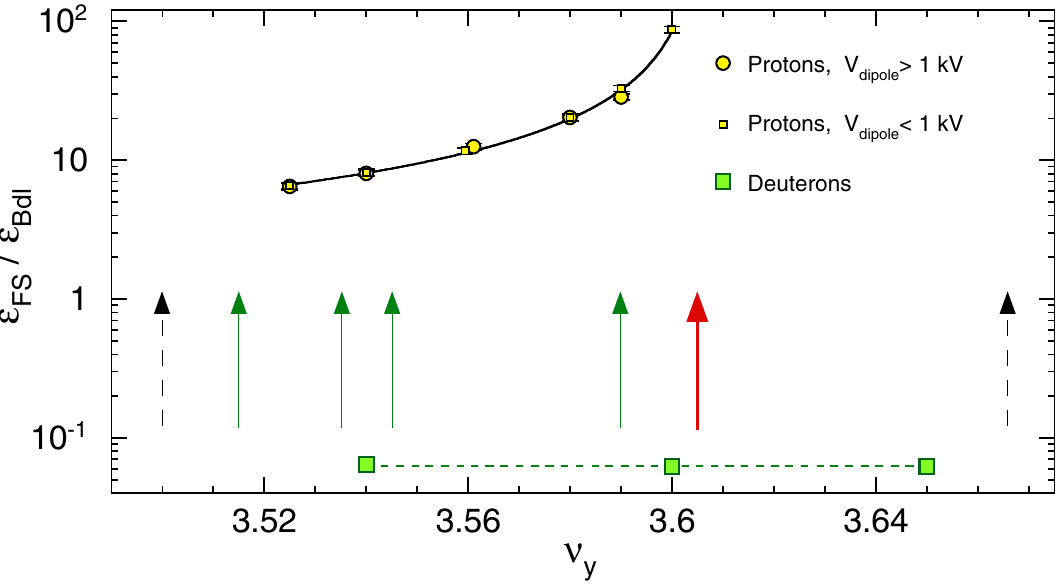
FIG. 6. (Color) Ratio of E to E is plotted vs the vertical betatron tune (cid:1) FS Bdl to Eq. (3); E is obtained using each data point’s R Bdl in Eq. (5). The proton data fit to Eq. (7), gives (cid:1) in the (cid:1) t curve for each (cid:1) y Bdl 3 : 6060 (cid:6) 0 : 0005 , A of 0 : 44 (cid:6) 0 : 46 and B of 0 : 50 (cid:6) 0 : 03 . Fitting the deuteron data to a horizontal straight line gives a resonance (cid:1) 0 : 063 (cid:6) 0 : 002 . The betatron beam resonances are shown by the black dashed arrows; the 1st and 3rd order = E strength ratio E FS Bdl proton spin resonances are shown by the red (bold) and green arrows, respectively.